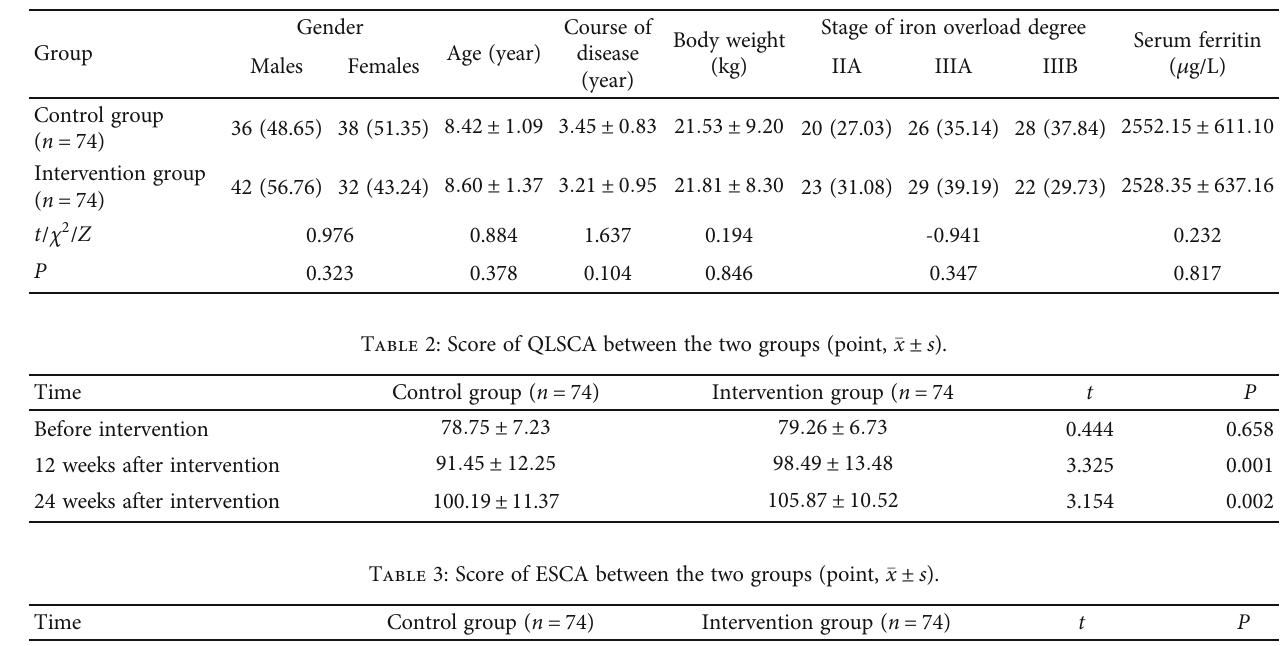
Table 1: General demographic characteristics of the patients at discharge for both groups ( (cid:1) x ± s , n (%)).